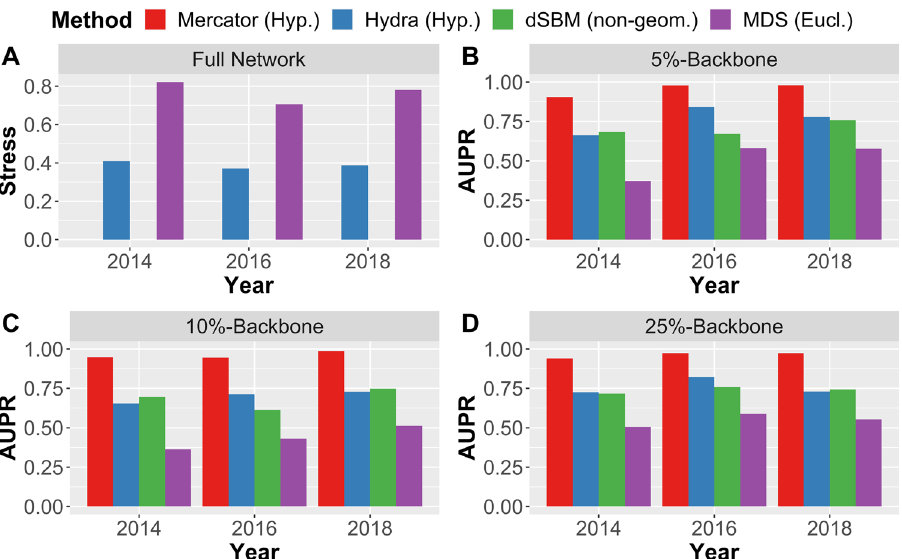
Figure 3. Panel ( A ): Stress (i.e. root mean square error) of network embeddings produced by hydra+ (hyperbolic target space) and multidimensional scaling/MDS (Euclidean target space). Lower stress values indicate better embedding quality. Panels ( B )–( D ): Area-under-Precision-Recall-curve (AUPR) for the task of reconstructing network backbones based on network representations produced by Mercator and hydra+ (hyperbolic target space), dSBM (non-geometric), and MDS (Euclidean target space). Higher AUPR values indicate better reconstruction